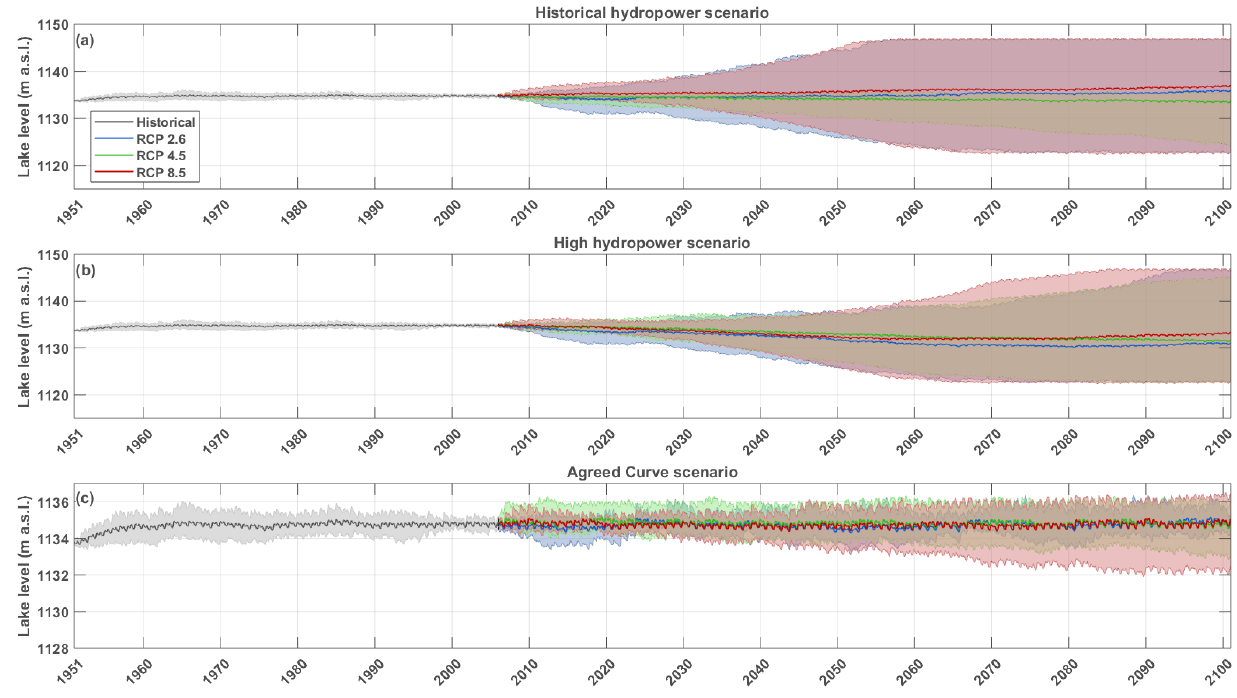
Figure 8. Lake level projections for the historical HPP management scenario ( P el is 168MW) (a) , the high HPP management scenario ( P el is 247MW) (b) and the Agreed Curve scenario (c) . The solid line shows the ensemble means and the envelope the 5th–95th percentiles of the CORDEX ensemble simulations, bias corrected using the parametric linear transformation method. Note the different y axis scale for panel (c)